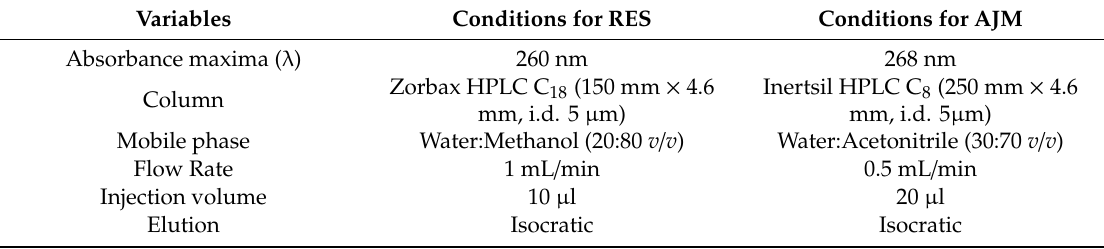
Table 8. Chromatographic conditions for RES and AJM RP-HPLC method with UV detection.